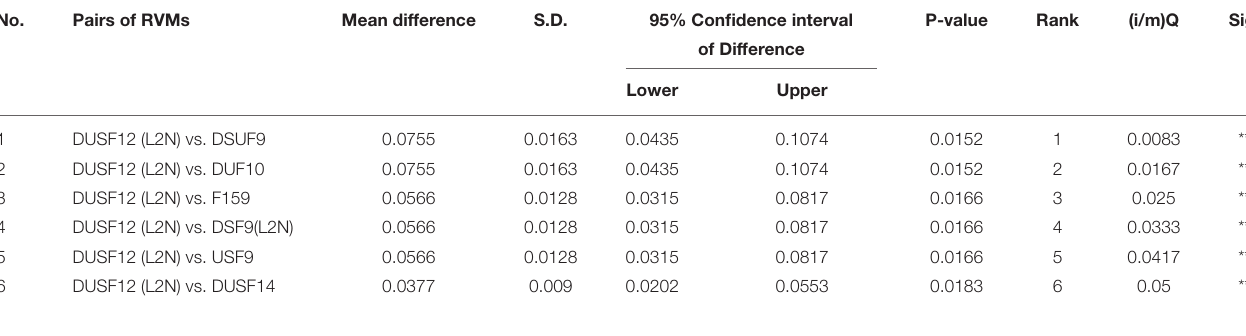
TABLE 6 | Paired sample t -test of the difference in sensitivity between the best model with other models. No.